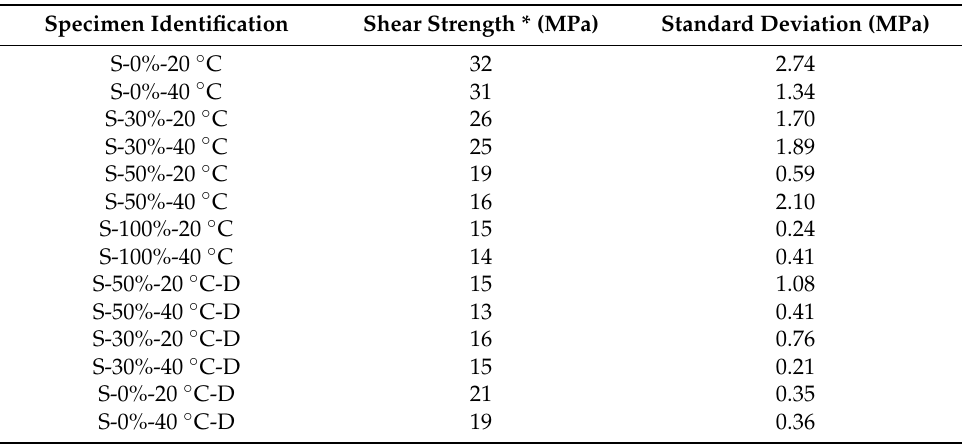
Table 4. Short-beam shear strength degradation of FRP